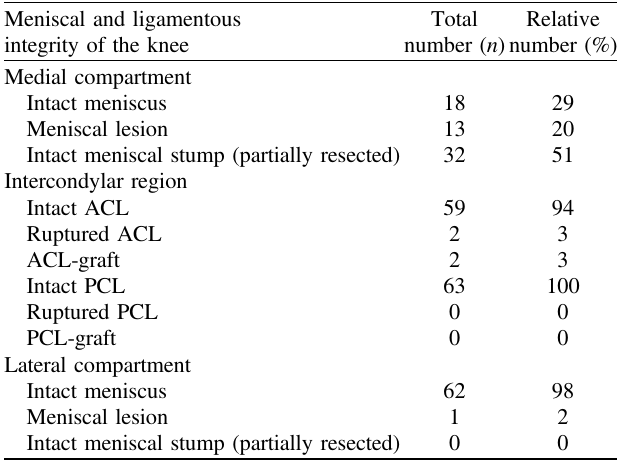
Table 4. Details on the meniscal and ligamentous integrity of the affected knee at the time of the HTO